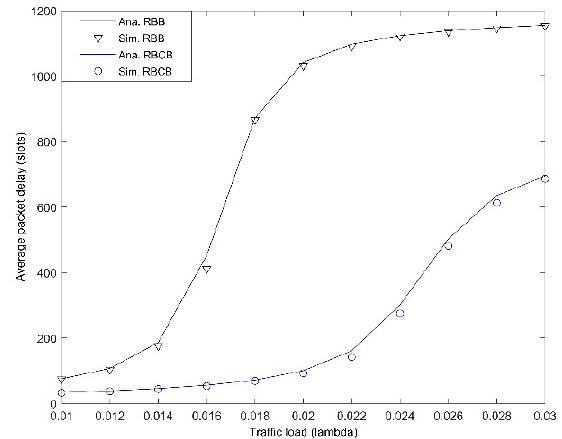
Figure 10. Comparison of average packet delay (APD).